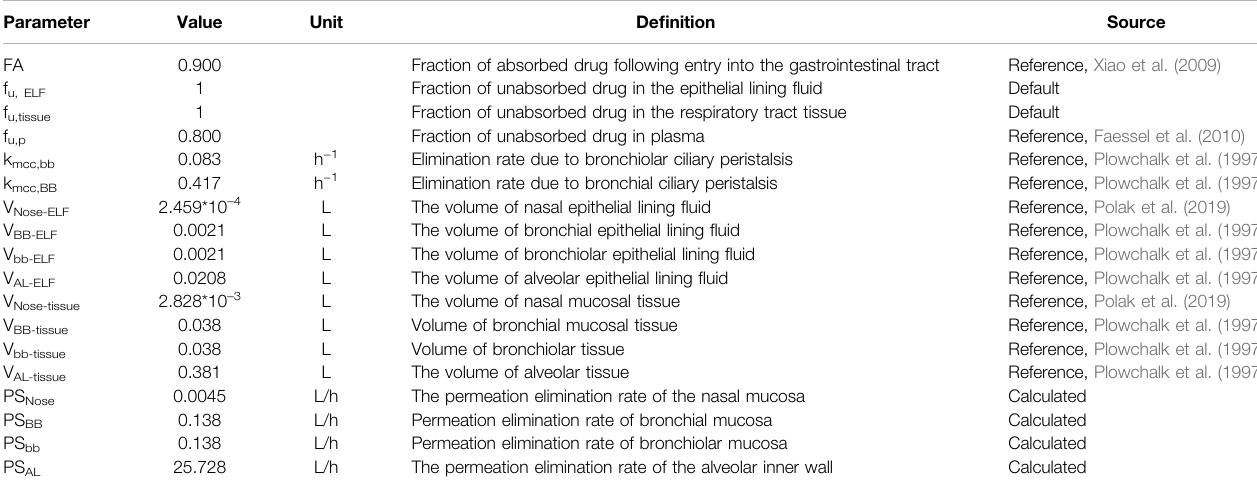
TABLE 1 | The fi xed parameters of the semi-PBPK model.